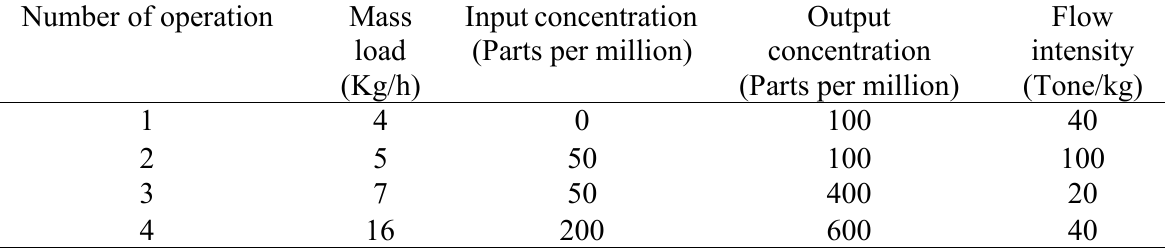
Table 1 . The analyzed data in Kuo and smith article (Kuo & Smith,